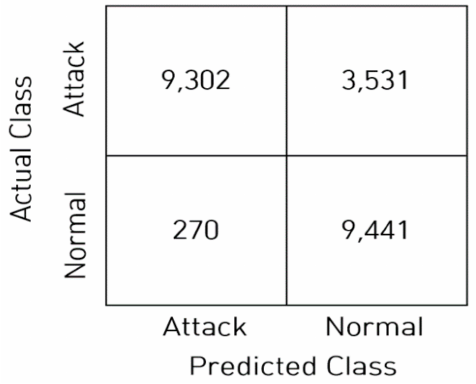
Figure 6. Confusion matrix for the